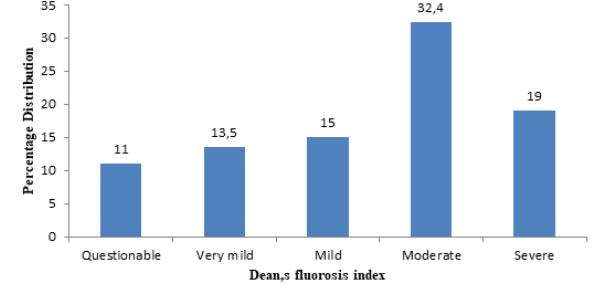
Figure 4: Dean’s fluorosis index for RM Participants.